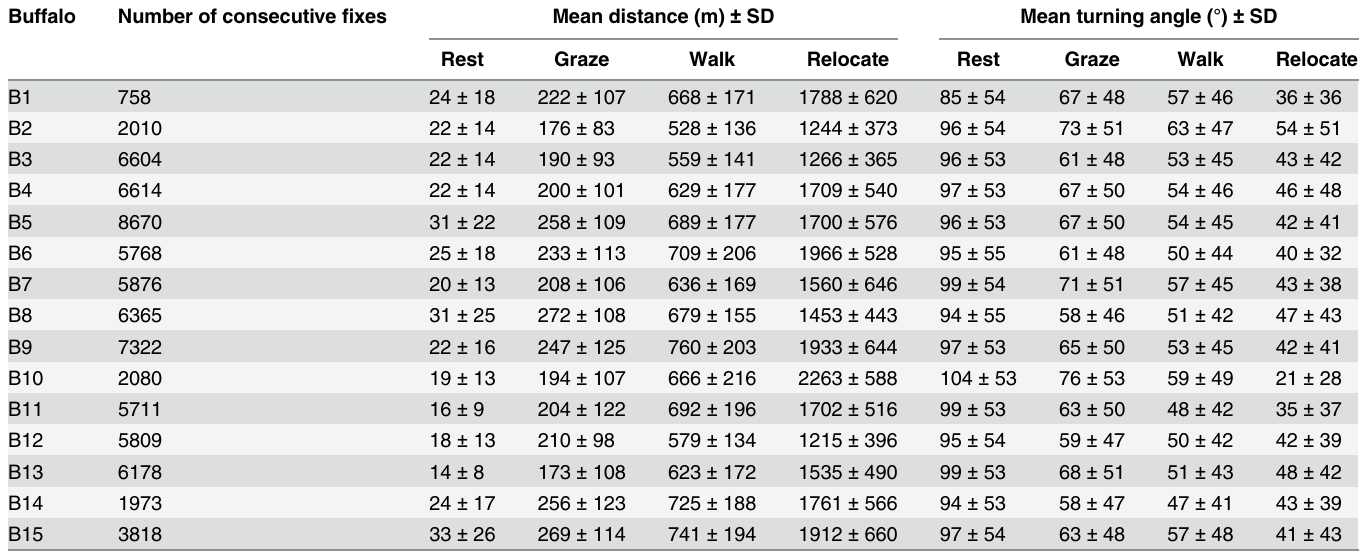
Table 2. Mean distances and turning angles defining behaviour, calculated by k-means cluster analysis on consecutive GPS fixes. Buffalo Number of consecutive fi